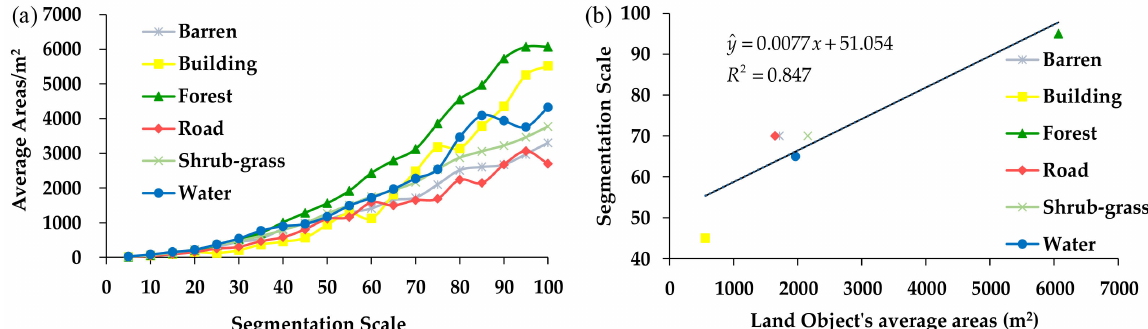
Figure 5. Relationship between the optimal segmentation scale ( a ) and the land objects’ average areas ( b